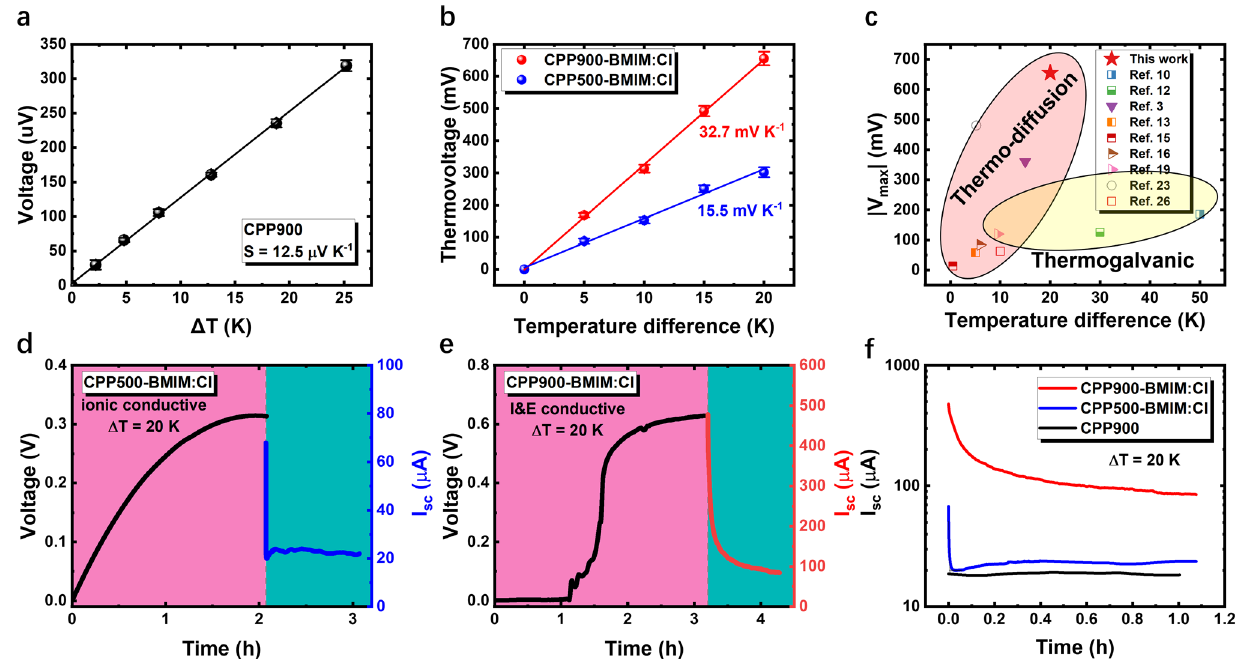
Fig. 2 a The thermopower of CPP900. b The thermopower of CPP500-BMIM:Cl and CPP900-BMIM:Cl determined by a liner fit of the open circuit voltage verses temperature difference. c Absolute thermovoltage of a single i-TE compared to reported values. The thermovoltage resulted from ion thermodiffusion effect is shaded in pink, and the thermovoltage due to thermogalvanic effect is shaded in yellow. Open circuit thermo- voltage curve and short circuit current curve of d CPP500-BMIM:Cl and e CPP900-BMIM:Cl. The cell size is 9 mm × 14 mm. f A comparison of short-circuit current among CPP900, CPP500-BMIM:Cl and CPP900-BMIM:Cl after thermal charging. (Color figure